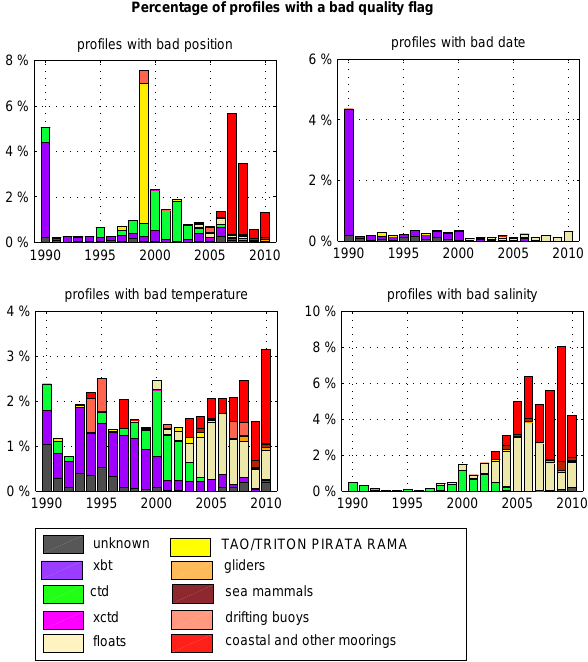
Fig. 10. Percentage of the profiles with bad quality flags in CORA3 as a function of time and data